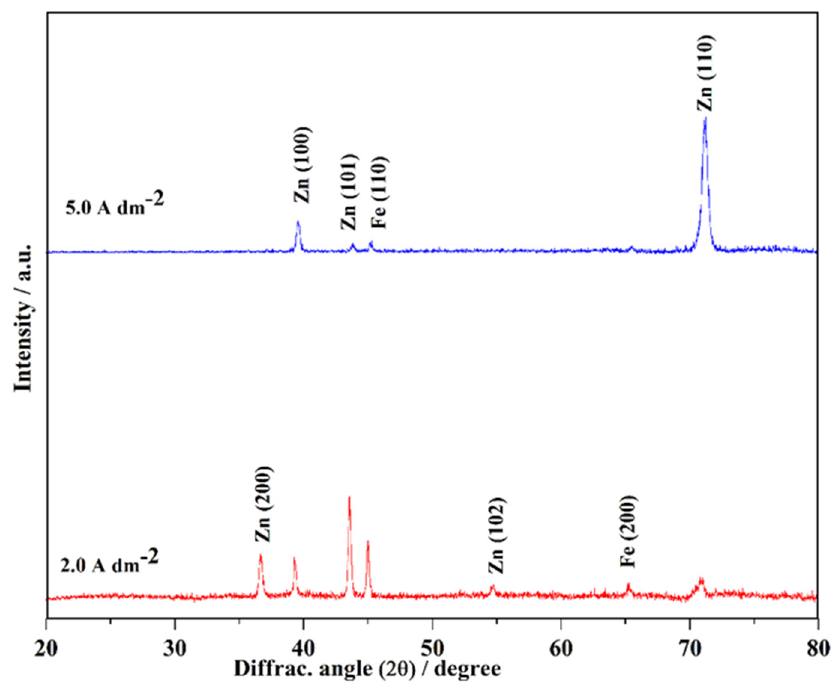
Figure 2. X-ray diffraction profiles of Zn-Fe alloy electroplate on MS developed from the optimized Figure 2. X (cid:3398) ray di ff raction pro fi les of Zn-Fe alloy electroplate on MS developed from the optimized bath at i = 3.0 and 5.0 A dm ‒ 2 . bath at i = 3.0 and 5.0 A dm − 2